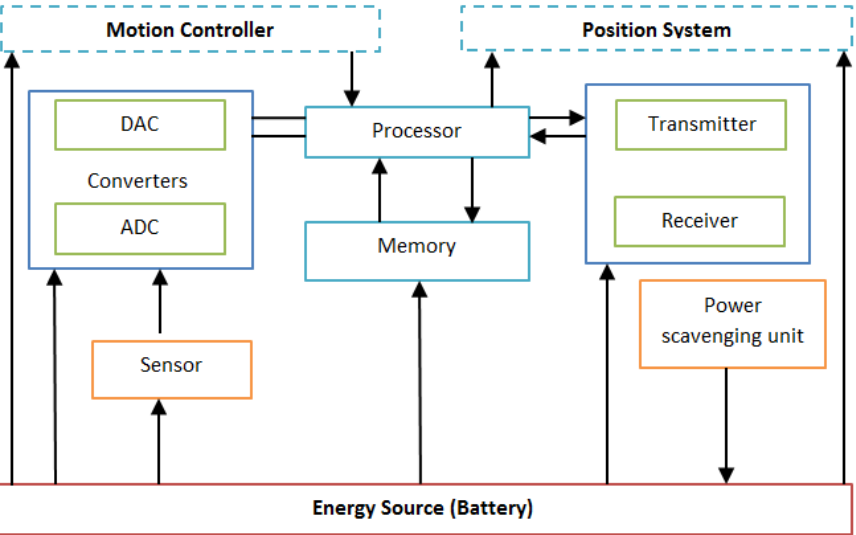
Figure 5. Generic sensor node structure.